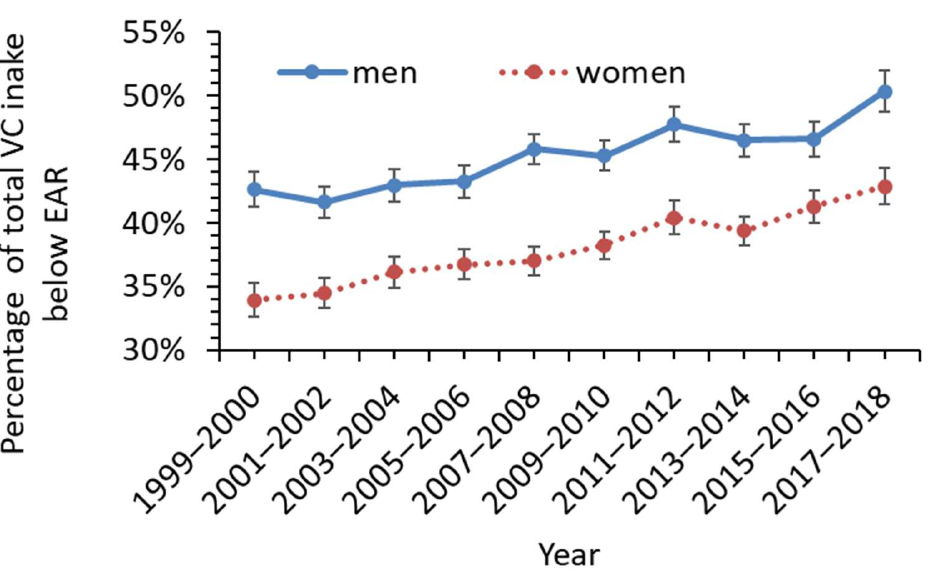
Figure 2. Rising trends of total VC intake below the estimated average requirements (EAR) for US adult men and women between 1999 and 2018. Vertical bars show standard errors.